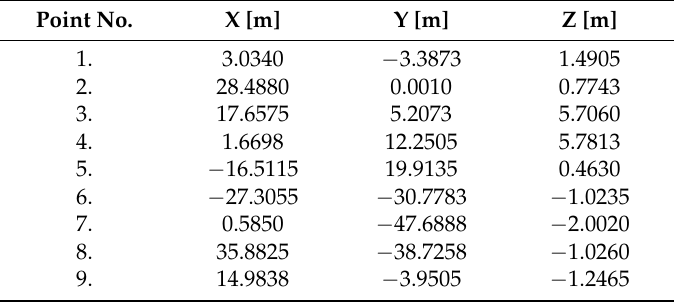
Table 10. Field surveying data with non levelled and non-centered instrument (Total Station), oblique and translated. Point